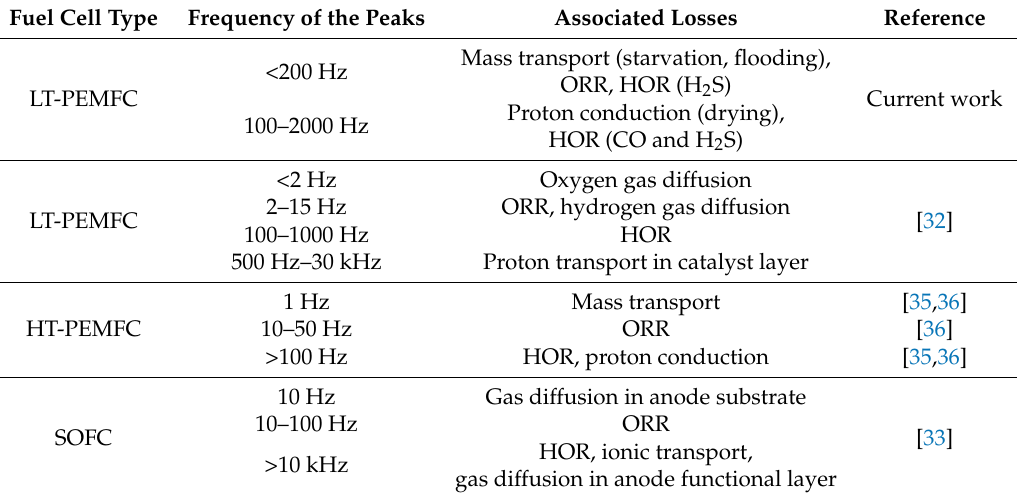
Table 2. Association of DRT peaks with fuel cell losses in the current work and in the